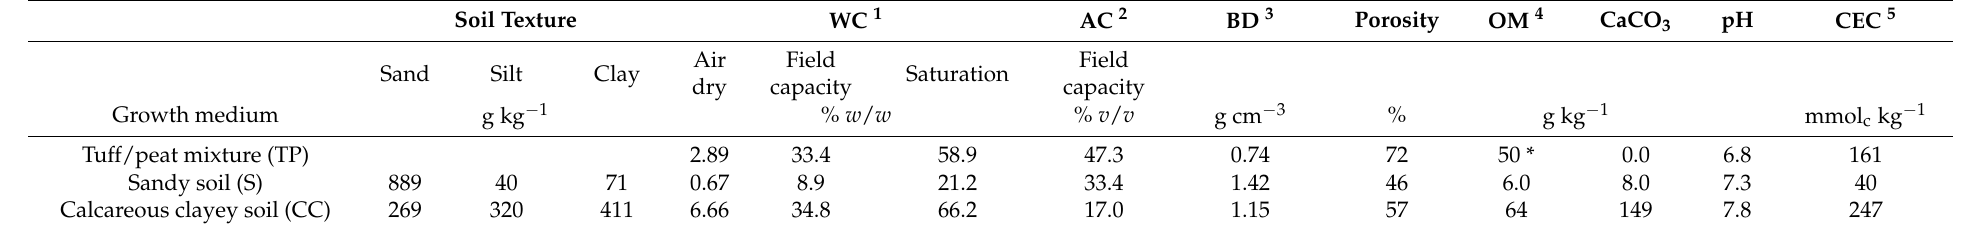
Table 1. The major properties of the growth media [tuff/peat mixture (TP), sandy soil (S) and calcareous, clayey soil (CC)] used to fill the pits established in a field of calcareous, clayey